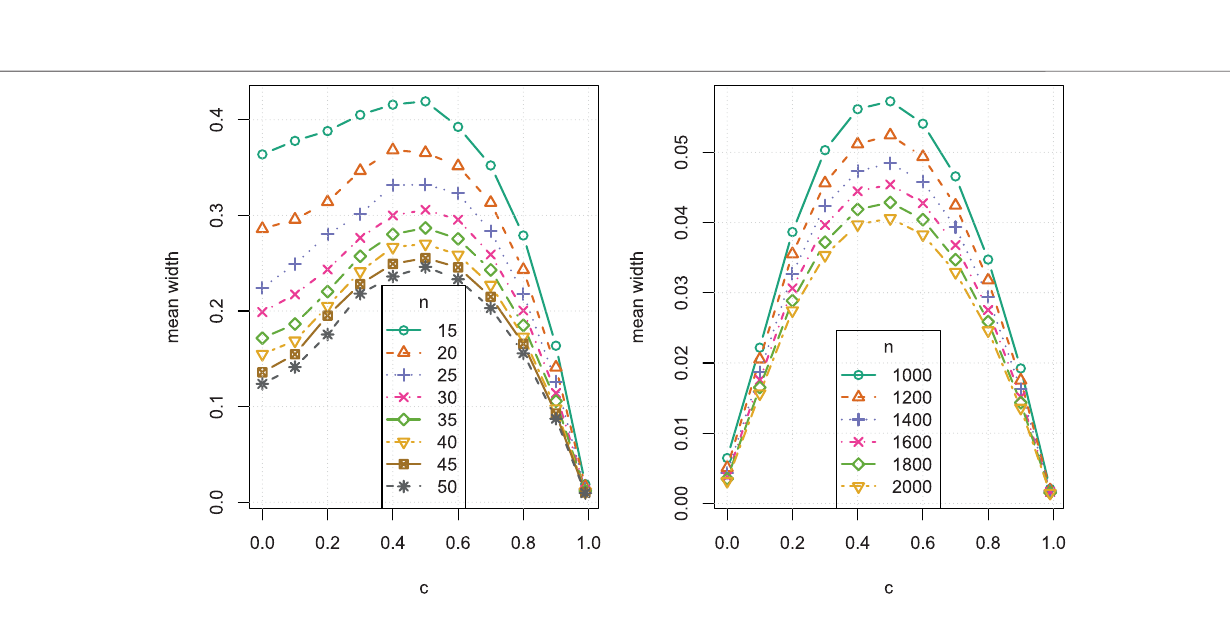
FIGURE8| Averagecon fi denceinterval widthversuscorrelationc,forsmall samplesizes n (cid:2) 15 , 20 , ... , 50(left) andlarge samplesizes n (cid:2) 1000 , 1200 , ... , 2000 (right), in MC Study A. The same patterns are present in MC Study B and